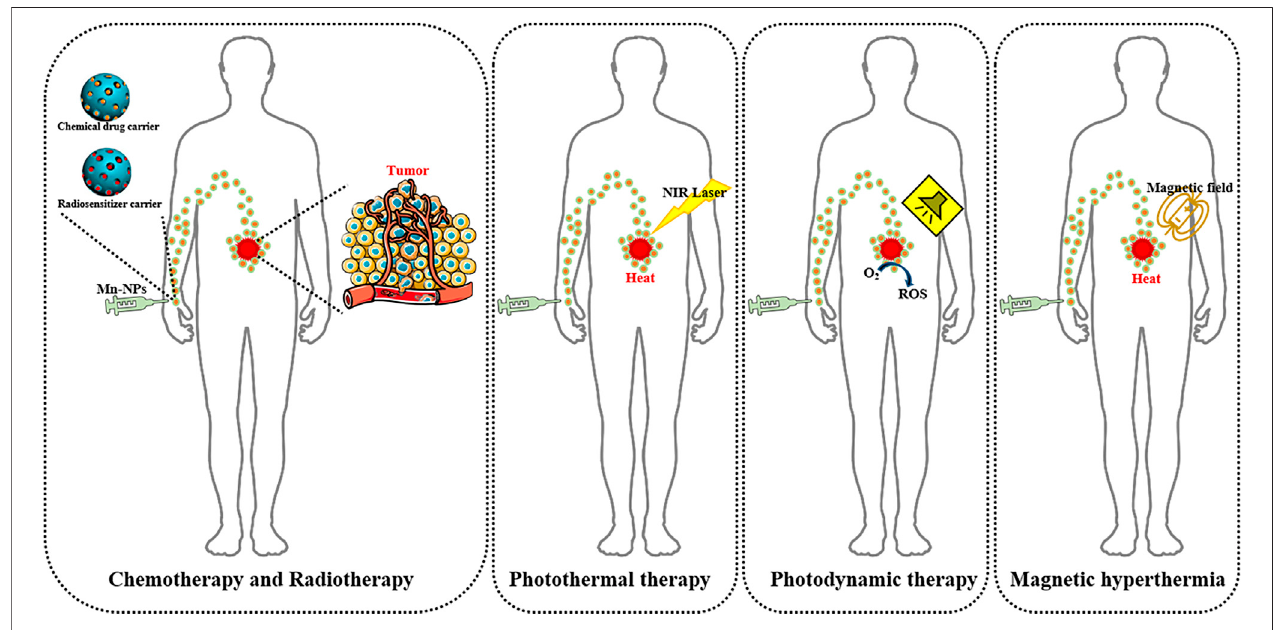
FIGURE 5 | Different approaches of Mn-NPs in cancer